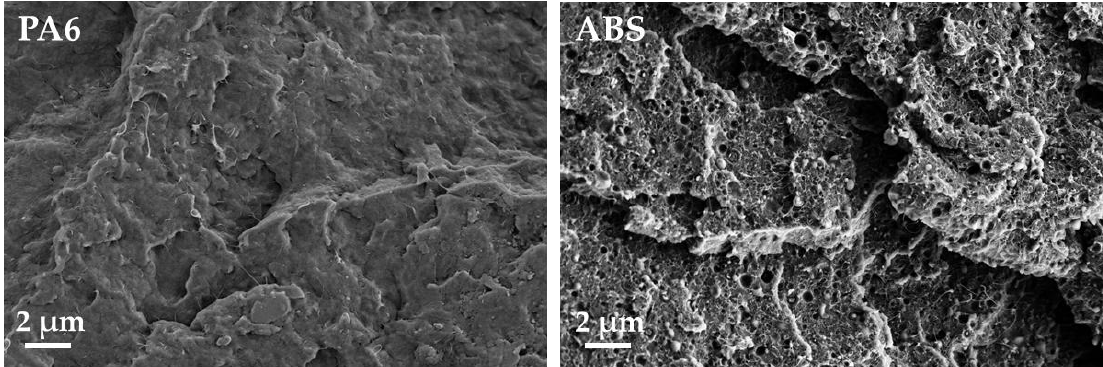
Figure 9. Transmission light microscopy images of polyamide 6 (PA6) and acrylonitrile butadiene styrene (ABS) filled with 1.0 wt% of SWCNT.